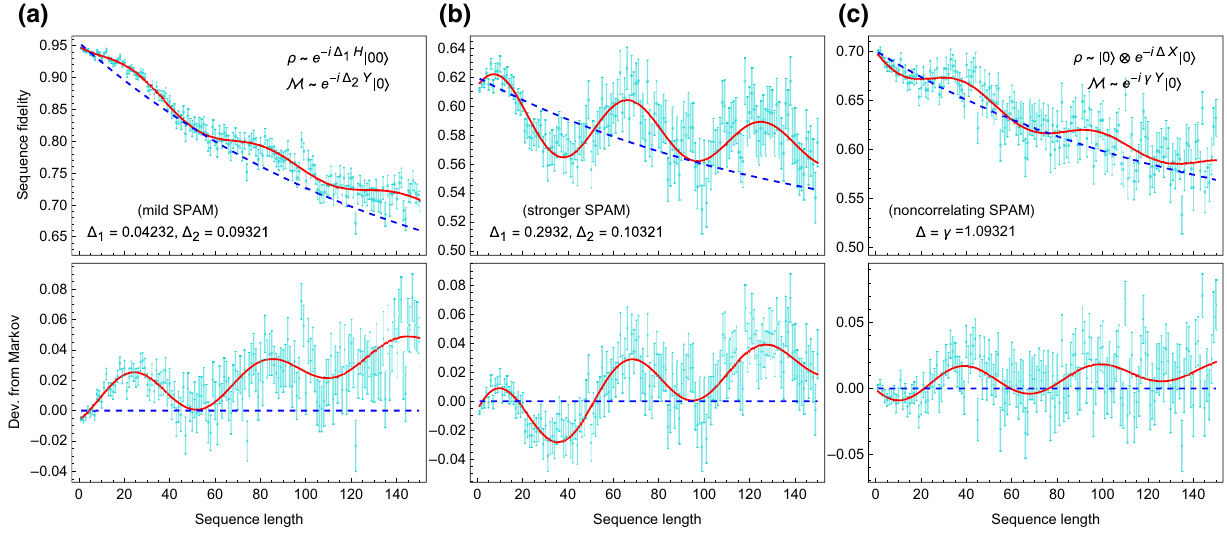
FIG. 12. Effect of SPAM errors in the two-qubit spin noise in Eq. (24). In the non-Markovian case, SPAM errors result in an offset but also appear to affect the error rates. In (a) and (b) the initial state is affected by the same sequence noise with (cid:3) exp ( − i (cid:12) 1 H ) for different values of (cid:12) 1 and M is slightly rotated via exp ( − i (cid:12) 2 Y ) with a small (cid:12) 2 . In (c) the initial state is only affected on system S with a rotation exp ( − i γ X ) and a relatively large γ . In all cases the sample size remains fixed at 100